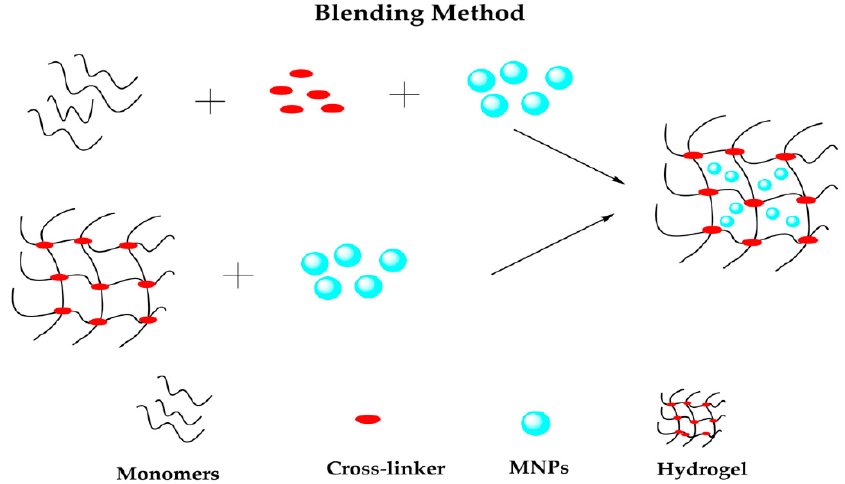
Figure 6. Schematic representation of blending method. Reprinted with permission from ref. [50], MDPI, 2022.